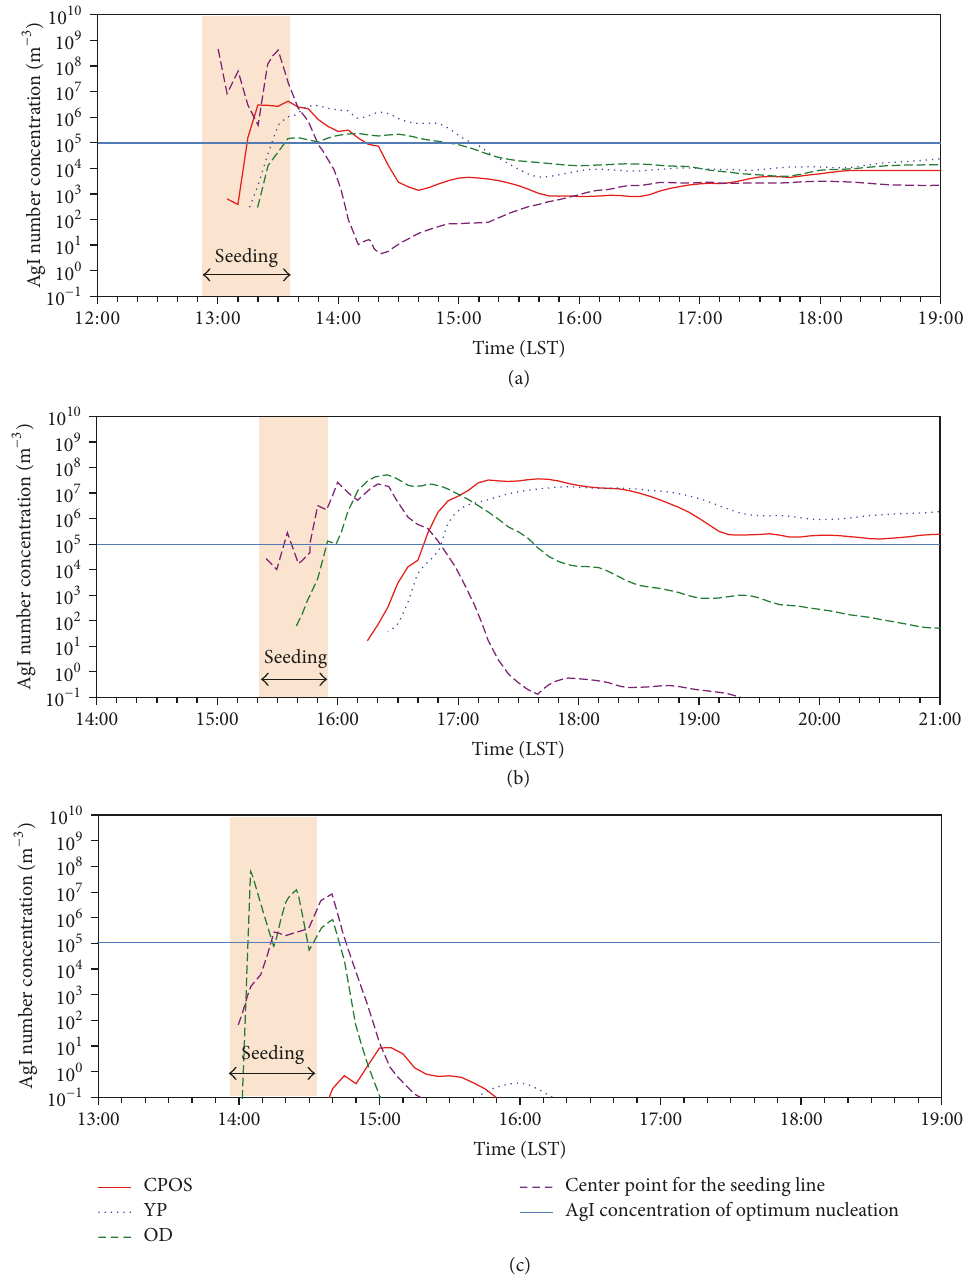
Figure 5: Time series of the vertically accumulated AgI number concentration (m −3 ) for the SEED simulations from the surface to the top level of the model in (a) EXP1, (b) EXP2, and (c) EXP3.